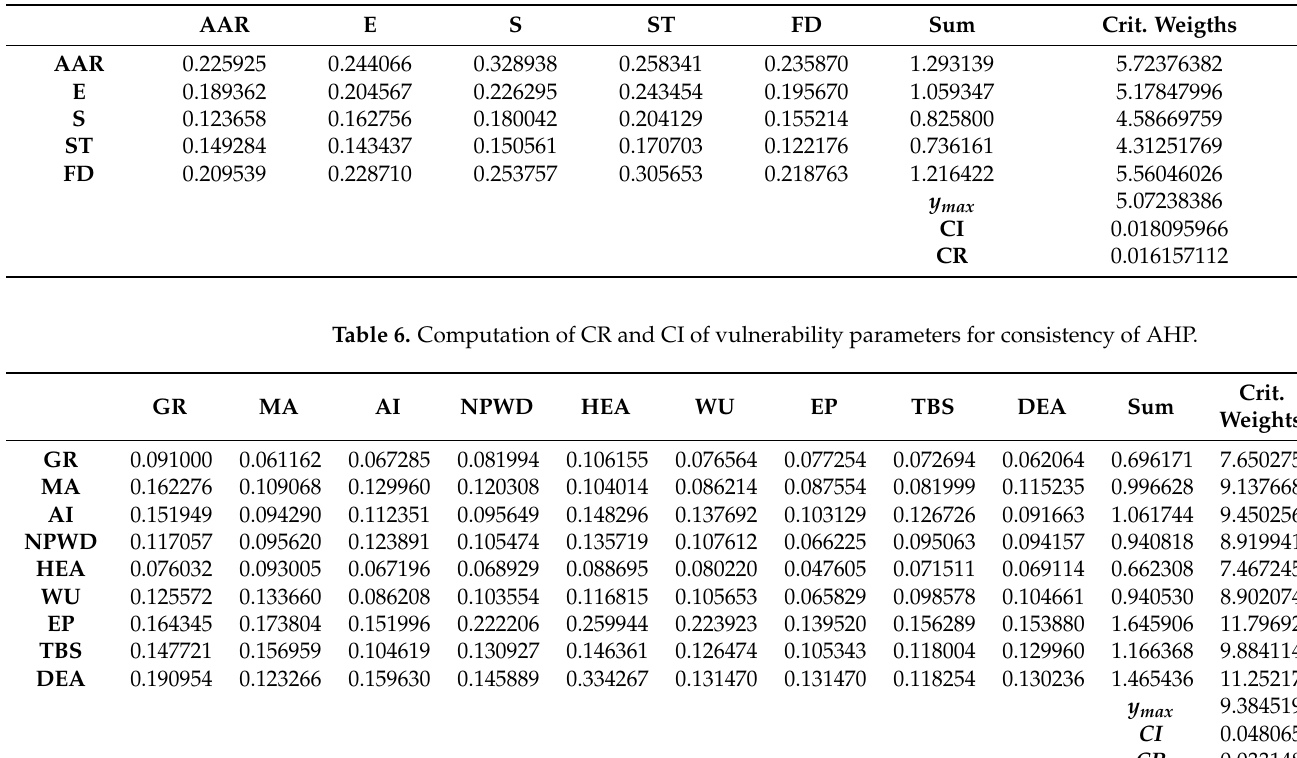
Table 5. Computation of CR and CI of hazard parameters for consistency of AHP.